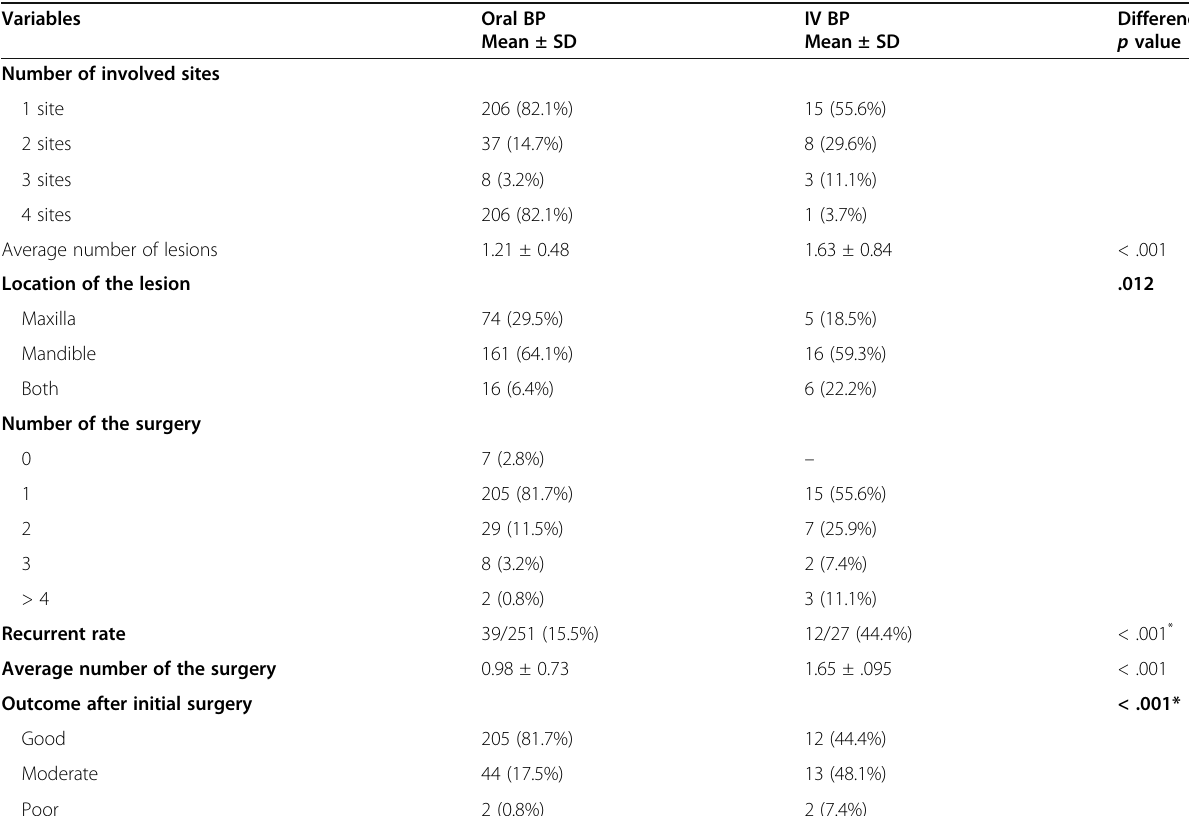
Table 2 Characteristics of the lesion and treatment results Variables